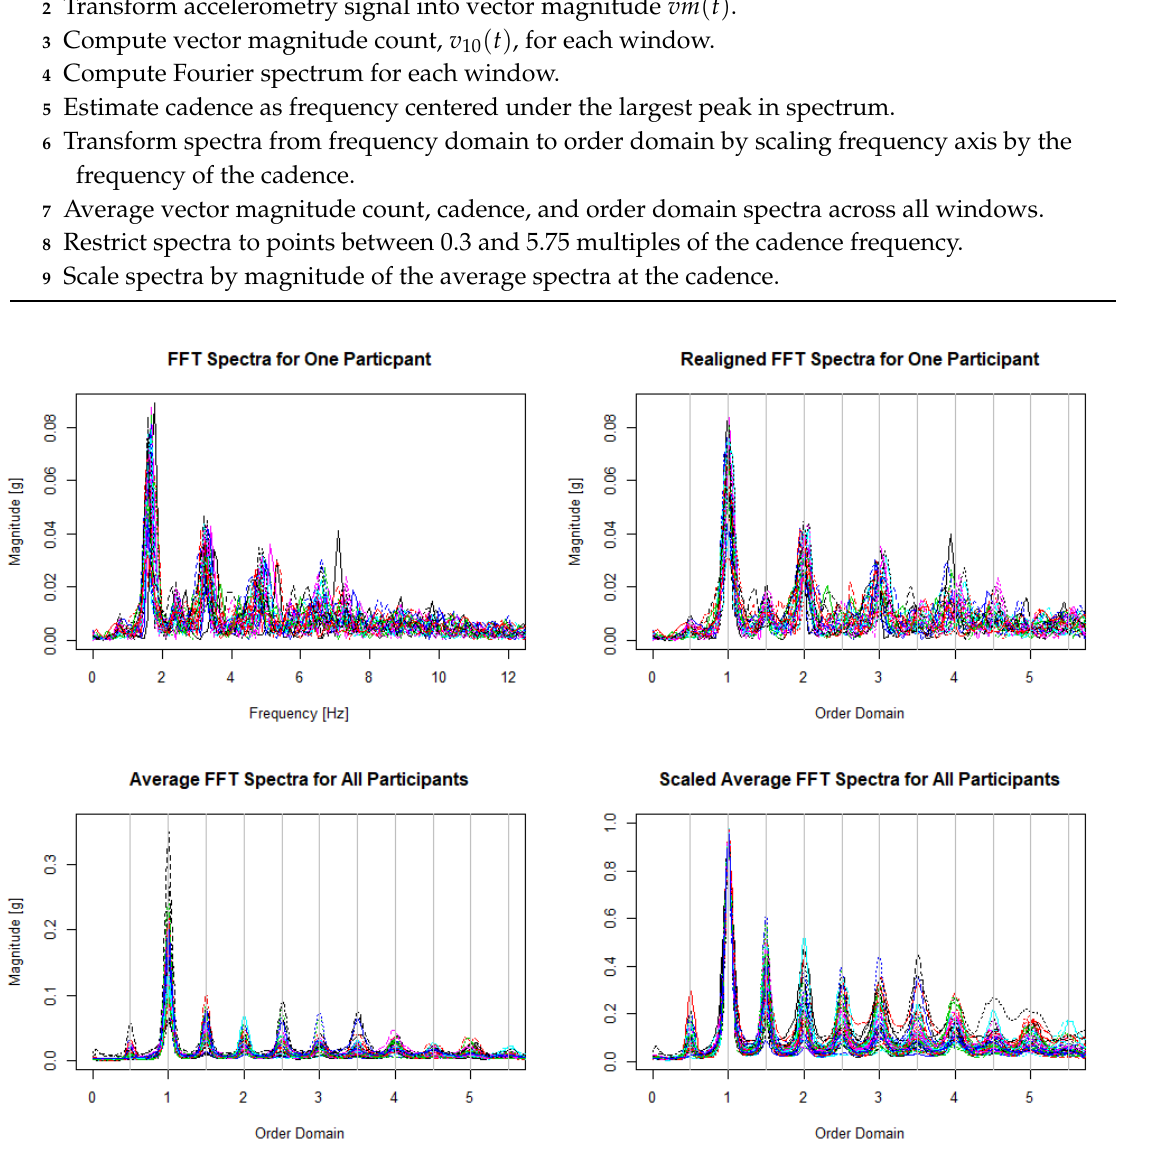
Figure 2. Pre-processing data. Observed FFT spectra for one participant as described in step 4 of Algorithm 1 ( top left ). Observed spectra realigned into order domain for the same participant as described in step 6 of Algorithm 1 ( top right ). Average realigned spectra for all participants as described in step 7 of Algorithm 1 ( bottom left ). Scaled average spectra for all participants as described in step 9 of Algorithm 1 ( bottom right